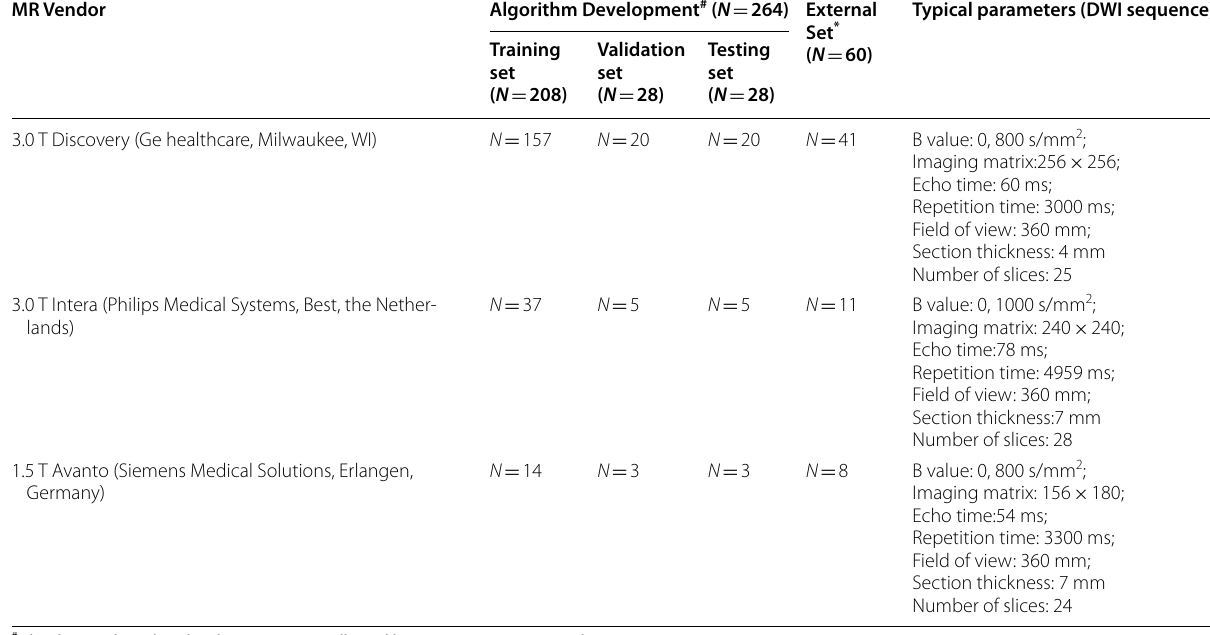
Table 1 Imaging system and typical parameters